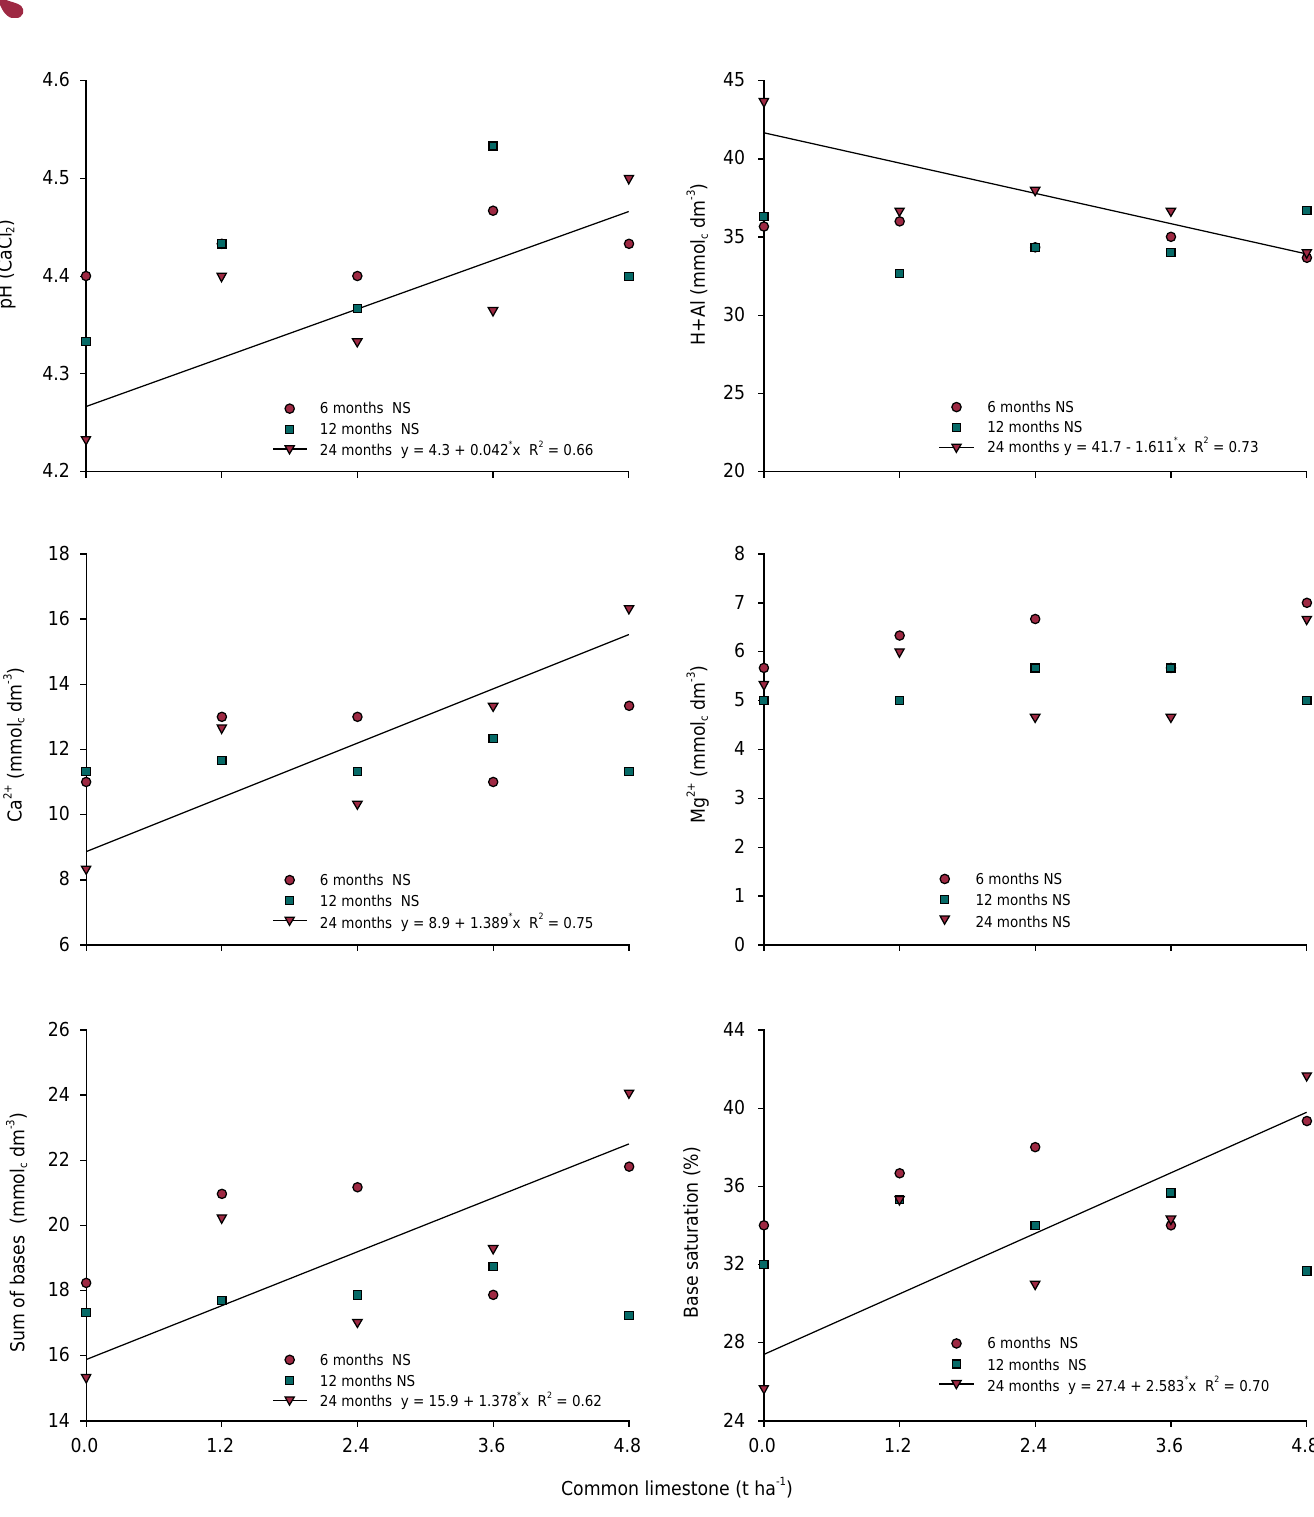
Figure 3. The pH value, potential acidity, Ca 2+ , Mg 2+ , sum of bases, and base saturation in the 0.10-0.20 m layer of an Argissolo Vermelho Amarelo [Ultisols (Soil Survey Staff, 2014)] in response to the rates of common limestone applied, without incorporation. The dots represent the averages of three replicates. ** and * indicate significance at 1 and 5 % probability,